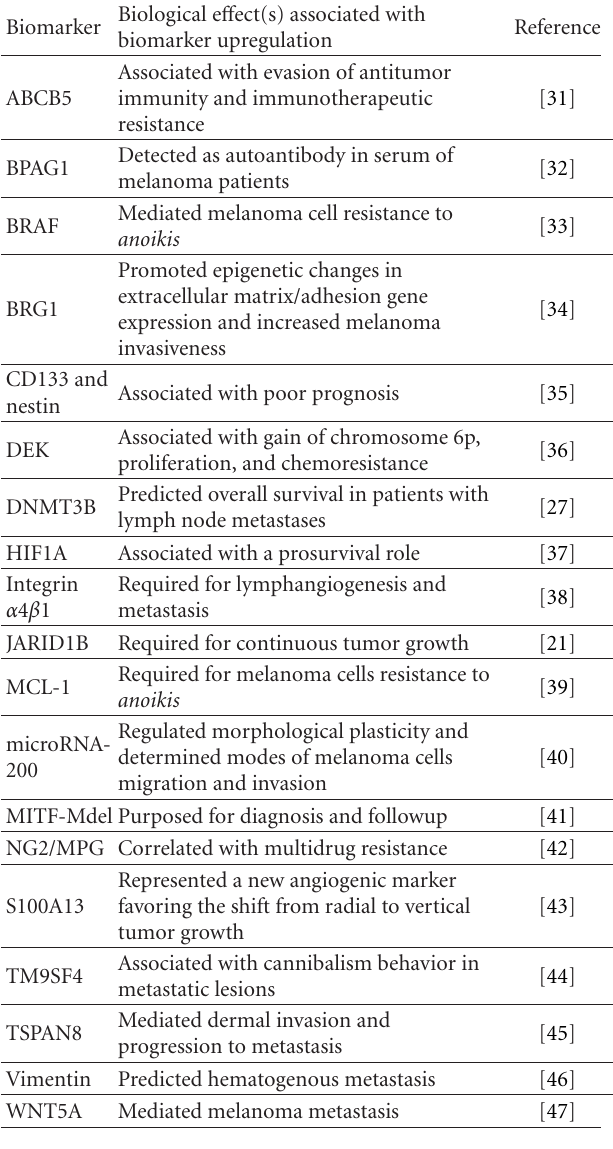
Table 1: E ff ects of candidates of oncogenic biomarkers in melano- ma